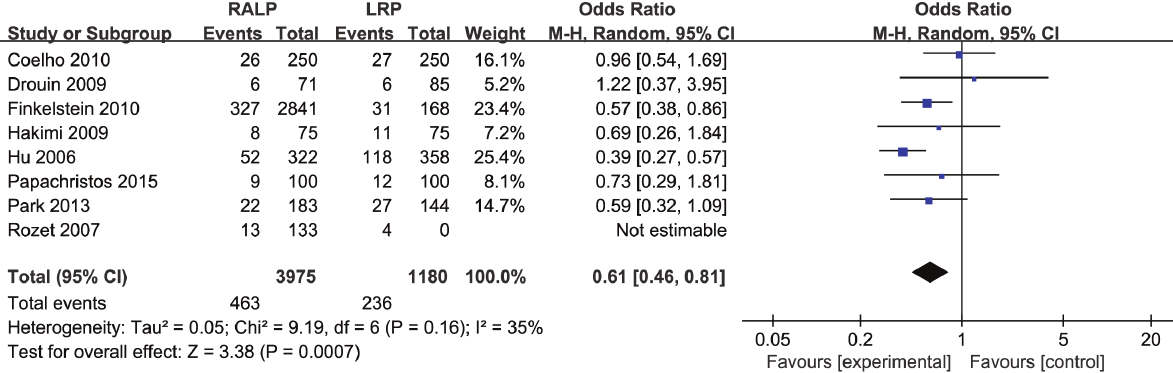
Figure 3: The forest plot for postoperative complications of RALP and LRP groups